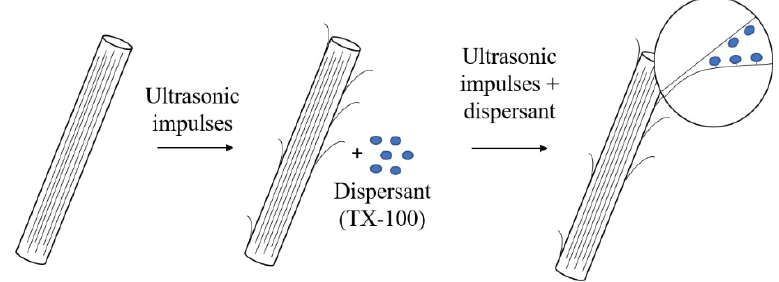
Figure 4. Gradual exfoliation process of MWCNT agglomerated scheme.